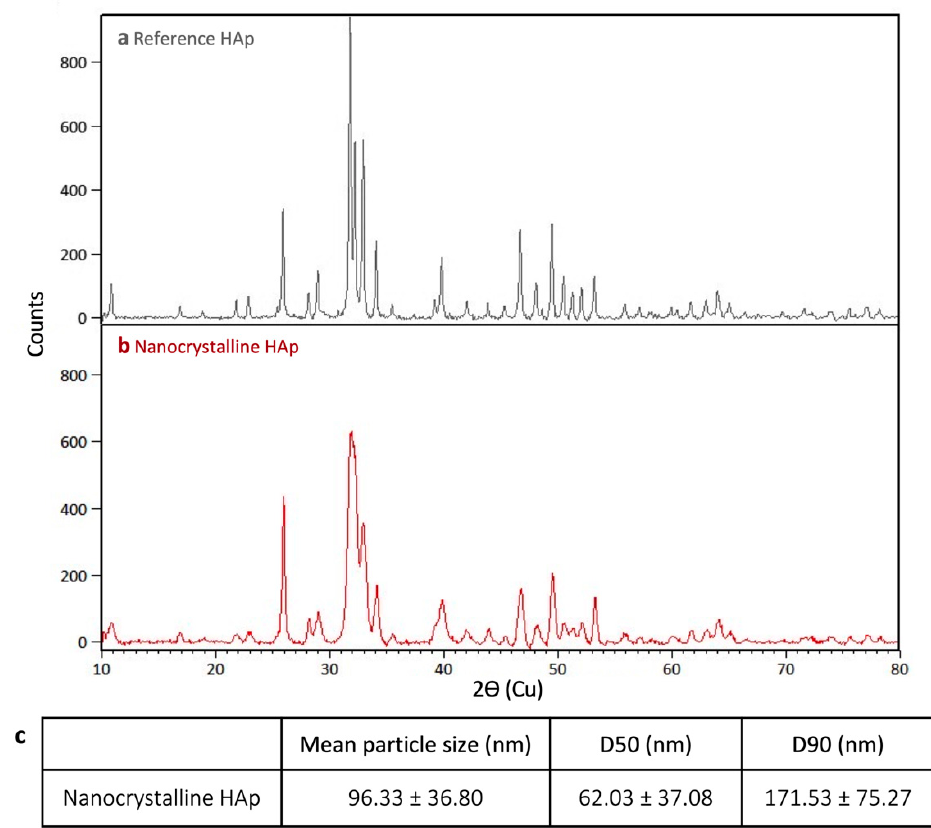
Figure 1. XRD scans of ( a ) reference HAp sample and ( b ) synthesized nanocrystalline HAp. ( c ) Nanoparticle tracking analysis of nanocrystalline HAp particle size (n = 3).